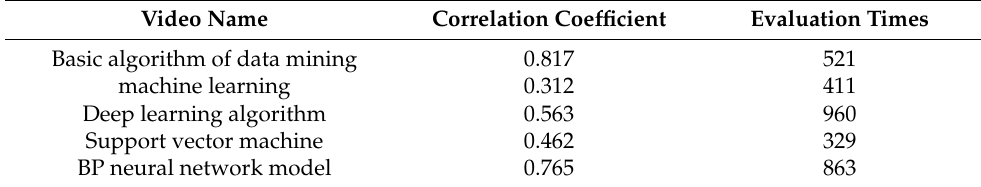
Table 13. Correlation coefficient and evaluation times table.